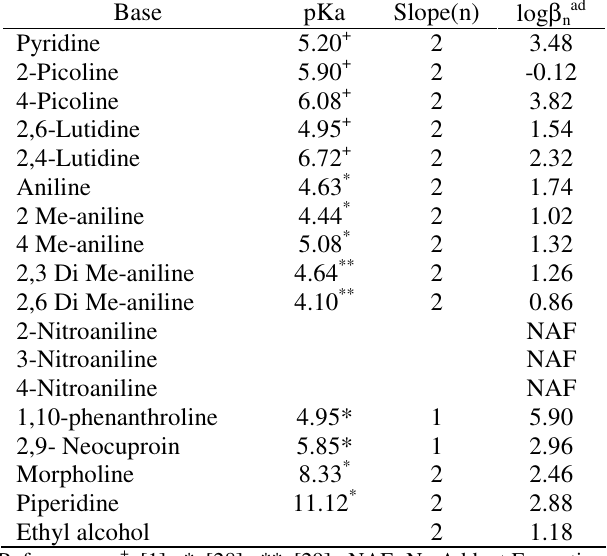
Table 1. Adduct formation constants of nickel(II)-4-methyl-8- quinolinate with nitrogen bases in chloroform